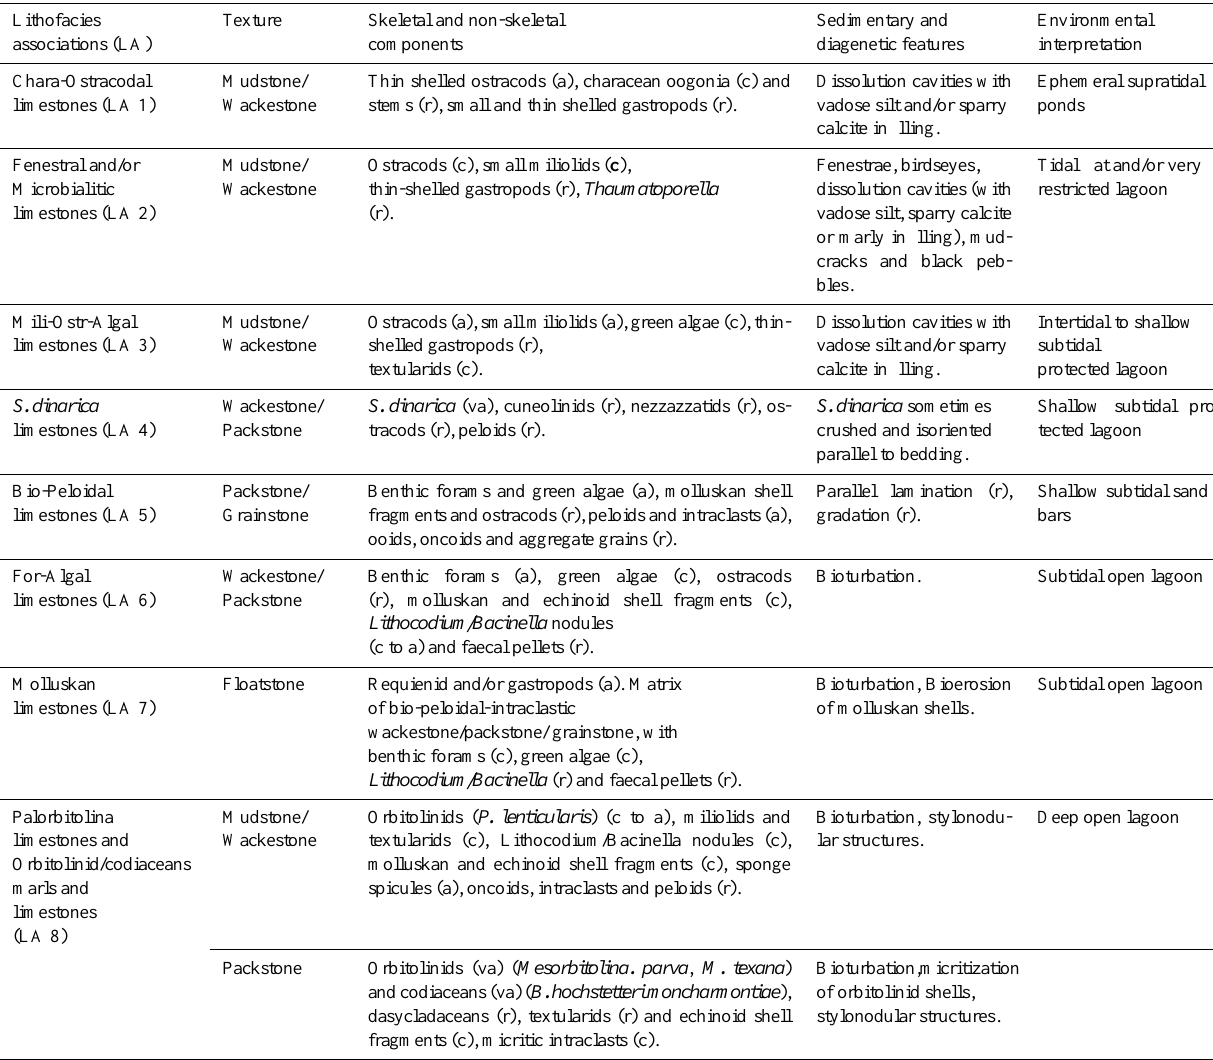
Table 1. Lithofacies description and palaeoenvironmental interpretation Lithofacies associations